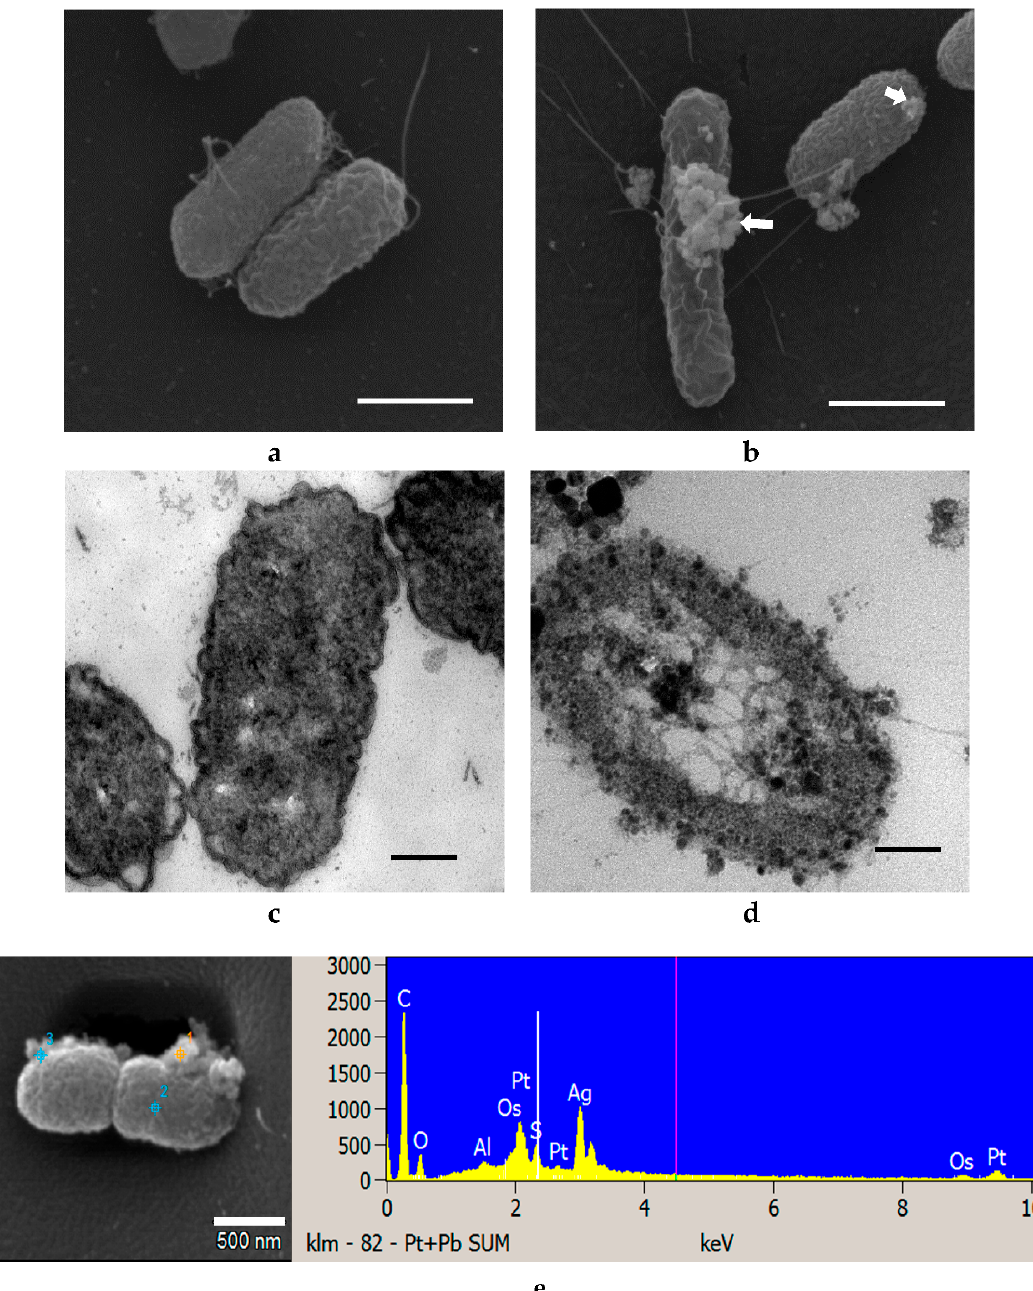
Figure 7. SEM ( a , b ) and TEM ( c , d ) images of E. coli untreated with Ag NPs ( a , c ) and treated with 4.6 mM Ag NPs ( b , d ). SEM-EDS analysis shows Ag NP presence on cell surfaces ( e ). White arrows indicated clusters of Ag NPs. SEM scale bar ( a , b ) = 1 μ m, TEM scale bar ( c , d ) = 0.2 μ m.